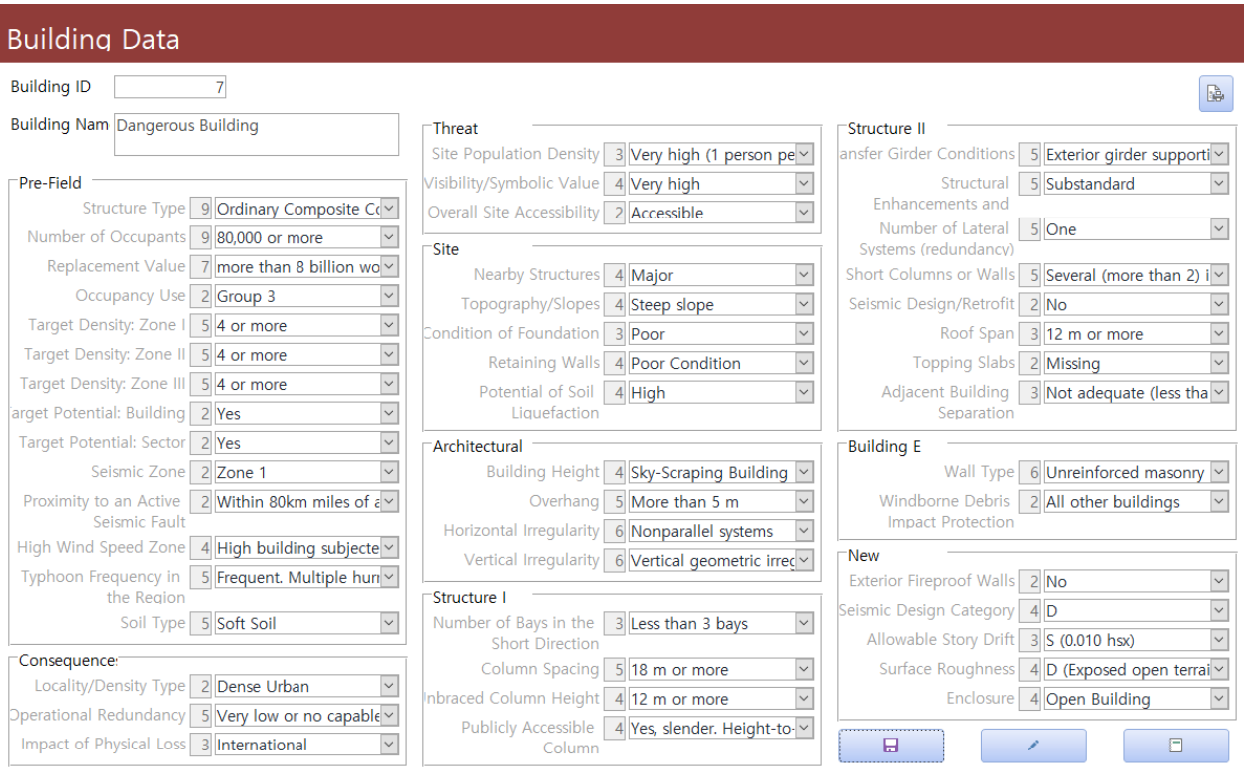
Figure 3. Example of K-RVS access system.